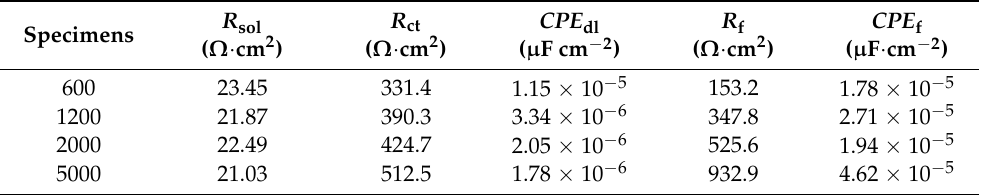
Figure 9. As the neutral salt spray time was extended, white corrosion products appeared